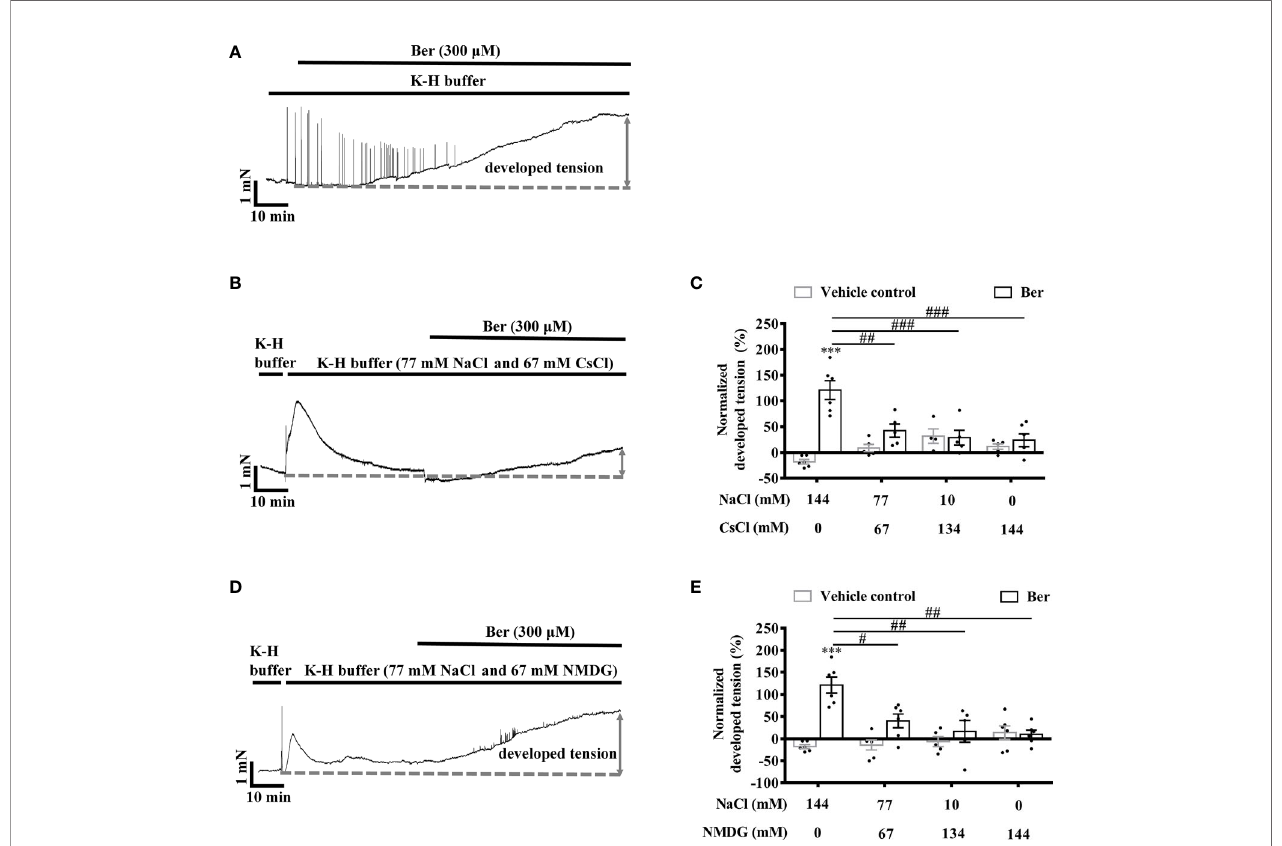
FIGURE 11 | The berberine-induced tension increase in left ventricular muscle (LVM) strips was extracellular Na + -dependent . (A, B, D) Original isometric tension recordings of the LVM strips treated with 300 m M berberine (A) , and 300 m M berberine under the low Na + condition where NaCl of the Krebs-Hensseleit (K-H) buffer was replaced with CsCl (B) or with NMDG (D) . (C, E) Summary data indicating that the 300 µM berberine-induced tension increase has a positive correlation with the concentrations of extracellular NaCl. The numbers of repeats are as follows: experiments with the normal K-H buffer, 300 µM Ber, n = 6, N = 6. Experiments with the K-H buffer in which NaCl was replaced with CsCl: 300 µM Ber in the buffer containing 77 or 10 mM NaCl, n = 5, N = 5; 300 µM Ber in the buffer containing 0 mM NaCl, n = 6, N = 6. Experiments with the K-H buffer in which NaCl was replaced with NMDG: 300 µM Ber in the buffer containing 77 or 0 mM NaCl, n = 6, N = 6; 300 µM Ber in the buffer containing 10 mM NaCl, n = 5, N = 5. n and N are the numbers of LVM strips and rats, respectively. Ber stands for berberine. ***p < 0.001 vs. vehicle control group; # p < 0.05, ## p < 0.01, ### p < 0.001 vs. Ber-treated group in the normal K-H buffer; two-way ANOVA with Tukey's multiple comparisons